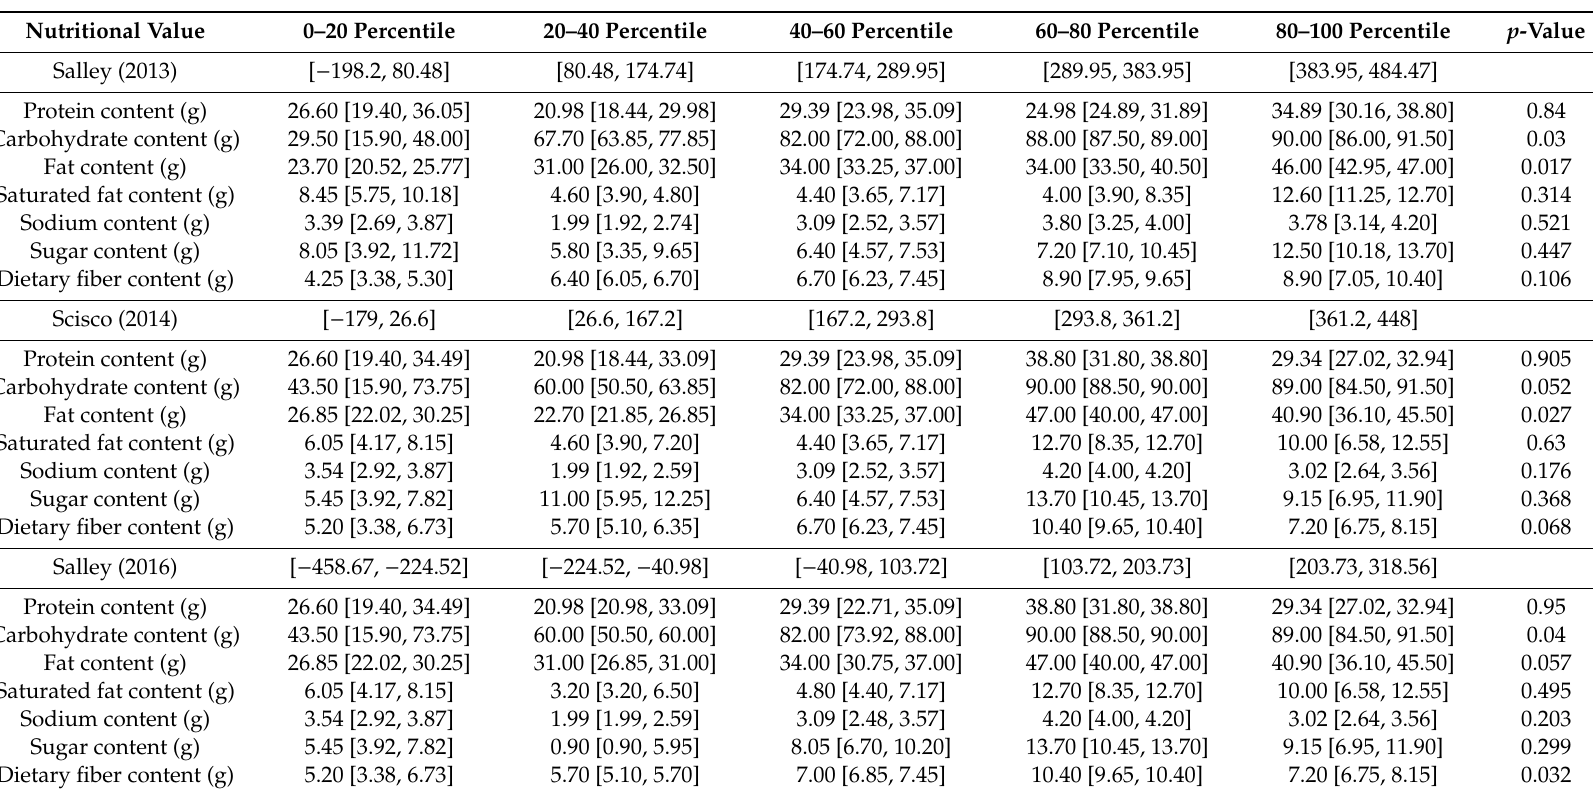
Table 4. Nutritional content values across percentiles of errors in estimated caloric intake in Kcal for Salley (2013), Scisco (2014), and Salley (2016). The rows where the author’s names are shown report the errors in the estimated caloric intake in Kcal. The results are reported as the median [I and III quartiles]. Di ff erences between median values were assessed using the Kruskal-Wallis